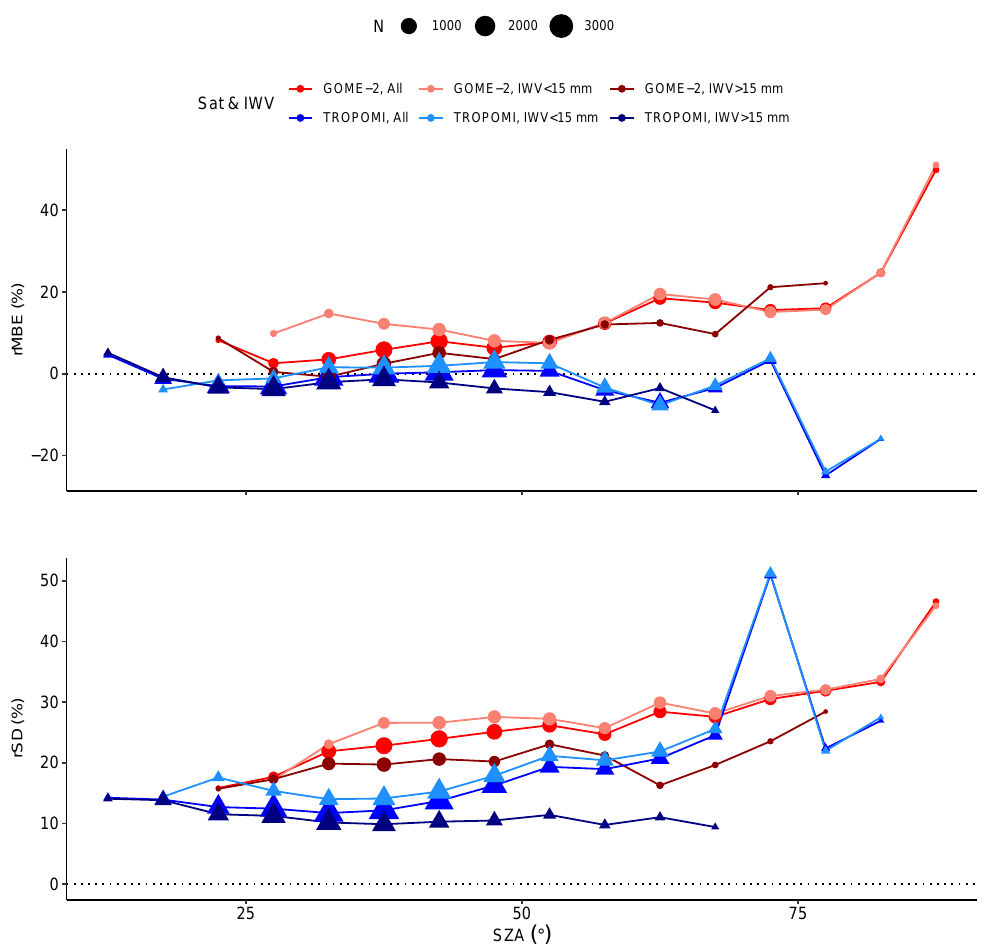
Figure 5. rMBE and rSD against SZA in bins of 5º. Data are also divided by high IWV (darker colors), all data (regular color) and low IWV (light